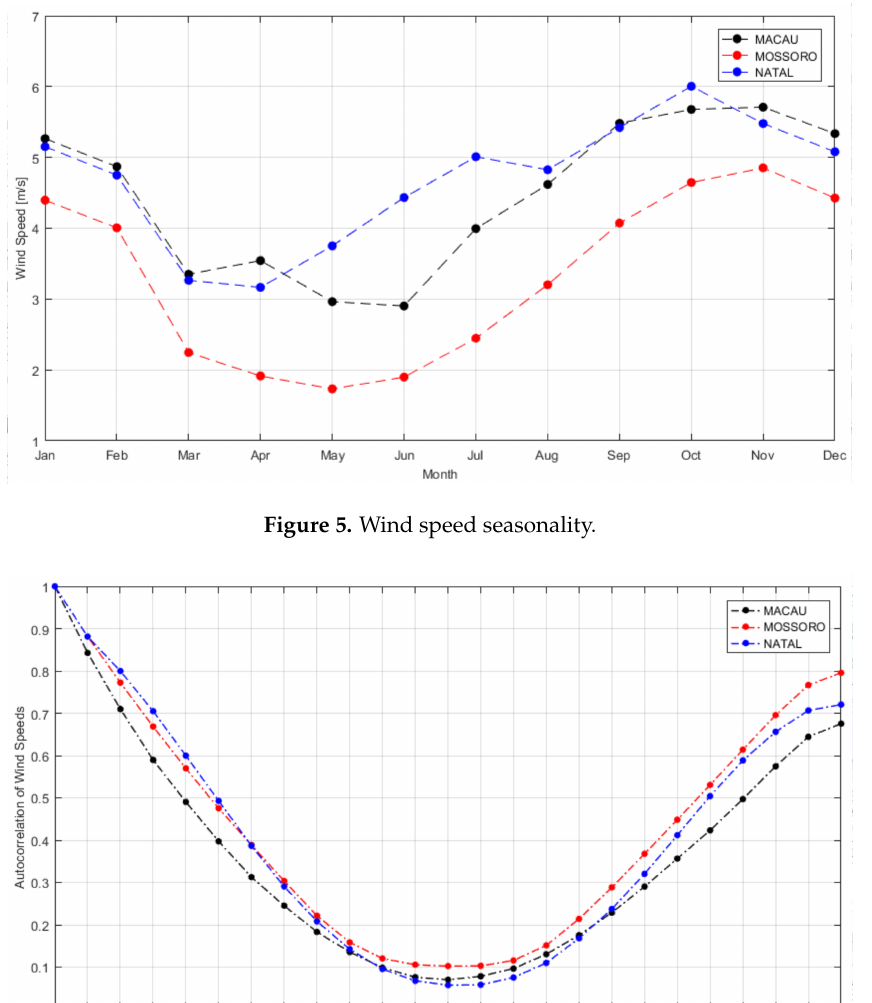
Figure 4. Wind speed for a typical day. Local time = UTC—3 h.